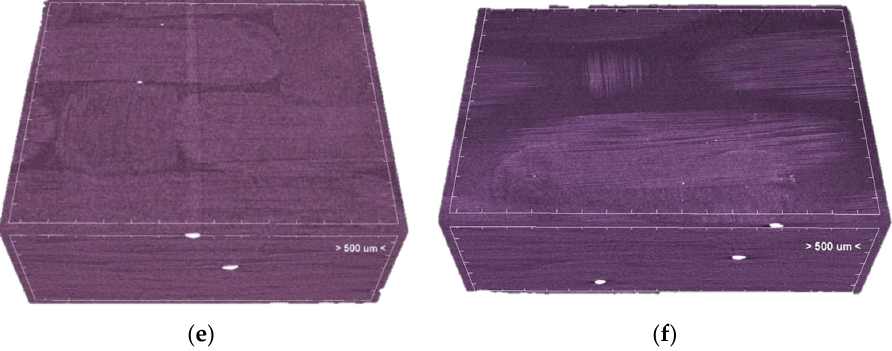
Figure 3. Internal structure of CFRP pre-exposure ( a ) untreated, ( c ) PMAA, and ( e ) APP; post-exposure ( b ) untreated, ( d ) PMAA, and ( f ) APP.